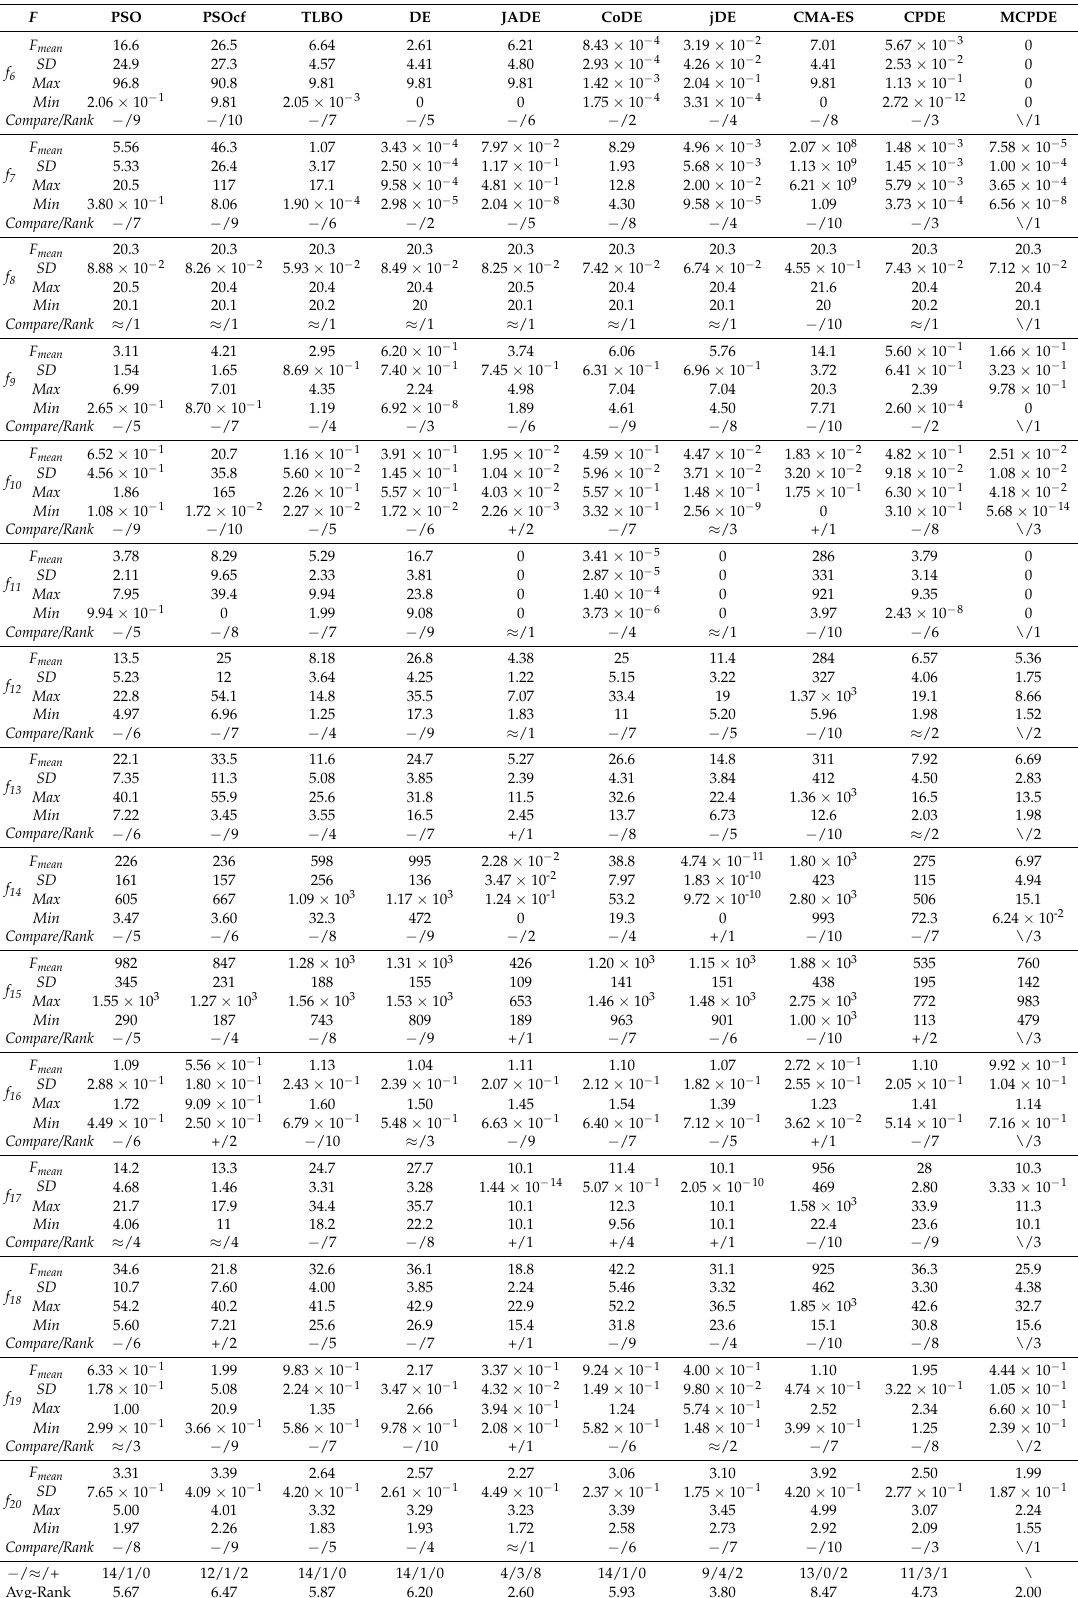
Table 3. Experimental results of PSO, PSOcf, TLBO, DE, JADE, CoDE, jDE, CMA-ES, CPDE and MCPDE over 30 independent runs on f 6 – f 20 test functions with 10 D